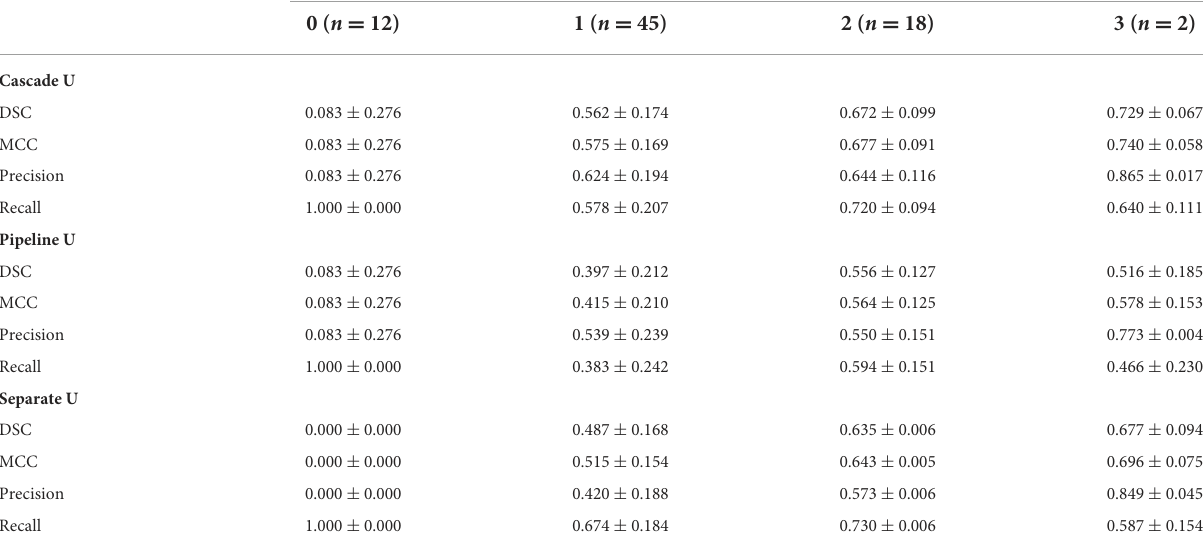
TABLE 3 Performance of three models on subjects’ pvWMHs with different Fazekas scores. Fazekas scores